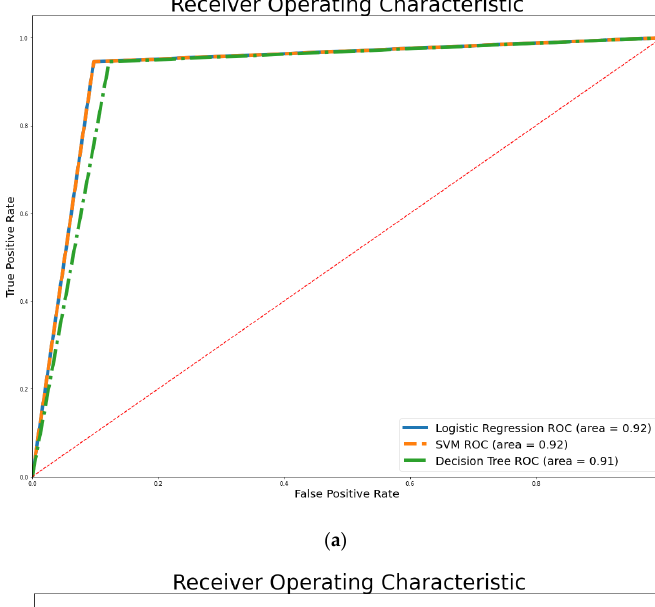
14 of 22 Figure 3. Confusion matrices: ( a ) SVM, ( b ) DT, ( c ) LR, ( d ) RF, ( e ) XGBoost, ( f ) AdaBoost, ( g ) ET. Figure 3 reveals that the ET model, which achieved the fewest FNs (two), is the best algorithm for predicting unwanted occurrences of the targeted disease, followed by the RF and XGBoost models, which failed to classify three cases of MS. Meanwhile, ET, XGBoost, LR, and SVM achieved the lowest rates of FP. Misdiagnosis of MS may occur due to pressure to deliver a timely diagnosis, as several alternative diagnoses may mimic MS, such as functional neurologic disorders, migraines, and arterial disease [41]. The mis- diagnosis of MS could lead to serious repercussions, including losing the chance for early treatment and possibly accelerating the course of the condition. Moreover, the risk of pro- longed, unnecessary healthcare hazards and death is often attributed to misdiagnosed MS